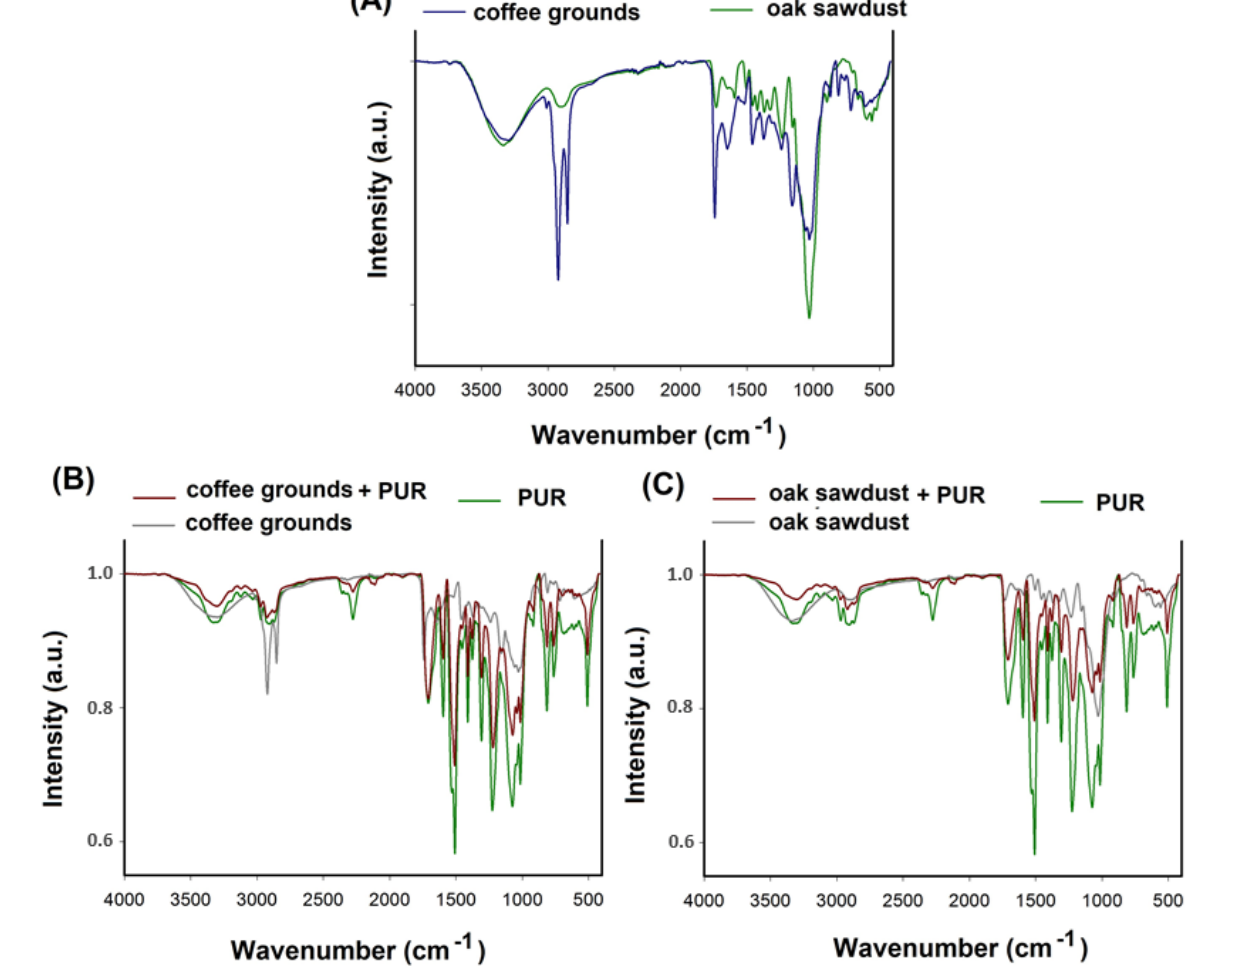
Figure 6. FT-IR spectra of powdered fillers ( A ), composites with the addition of coffee grounds ( B ), and oak sawdust ( C ).